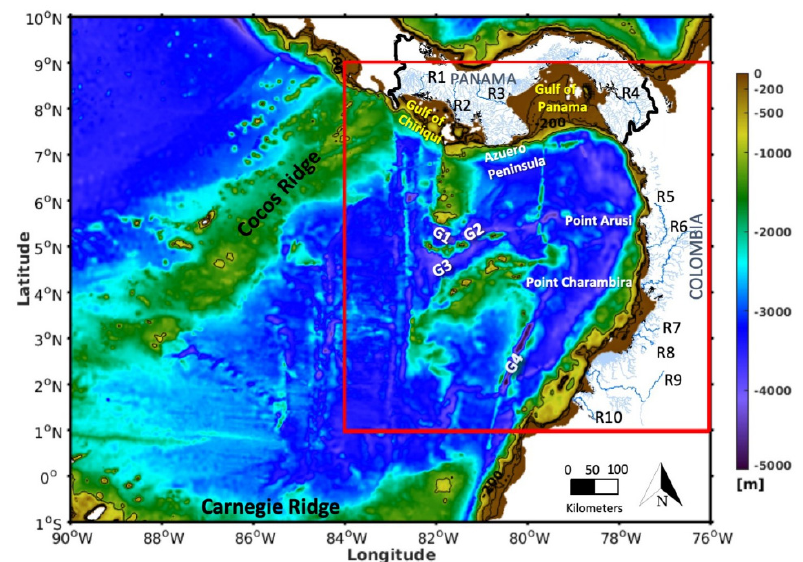
Figure 1. Study area of Panama Bight (1–9 ◦ N, 76–84 ◦ W; red rectangle) in the Eastern Tropical Pacific region. Bathymetry features (in color), main rivers (R1: Chiriqui, R2: Fonseca, R3: Santa Maria, R4: Tuira, R5: Baudo, R6: San Juan, R7: Naya, R8: Micay, R9: Patia, R10: Mira) and submarine depressions (G1: Yurupar, G2: Guanibos, G3: Omagua, G4: Yaquina) are specified for the study area enclosed in a red box.